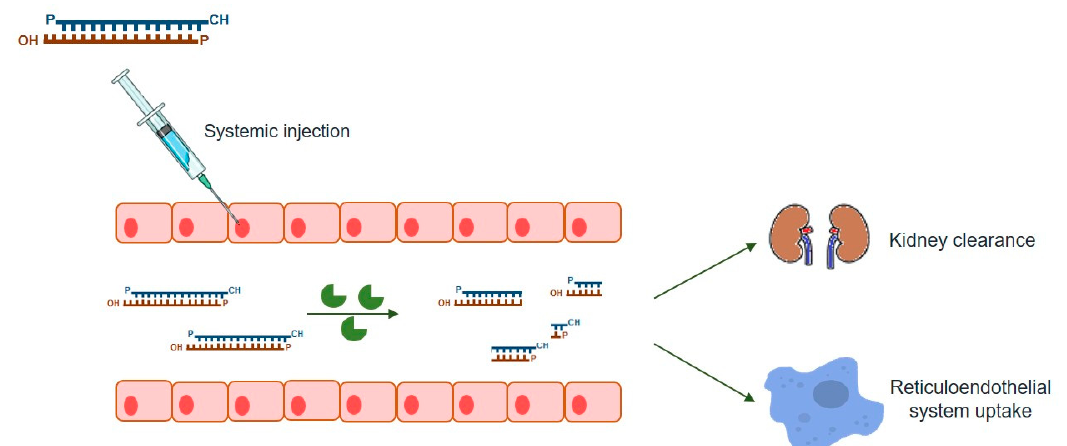
Figure 2. Barriers to the systemic delivery of siRNAs nanoparticles. In vivo, siRNAs systemic delivery faces several barriers, namely: stability in the blood stream; transport across the vascular endothelial barrier; diffusion through the extracellular matrix and endosomal escape. Upon systemic administration, nano-sized carriers might be rapidly cleared from bloodstream by the reticuloendothelial system (RES) and phagocytosed by the mononuclear phagocyte system (e.g., macrophages and liver Kupffer cells). These clearance processes, mediated by the interaction of the nanoparticles with blood components (e.g., immunoglobulins of the complement system), result in higher particle accumulations in RES organs, such as liver and spleen, relative to non-RES organs; therefore, decreasing the amount of nanoparticles that reaches organs such as the brain.